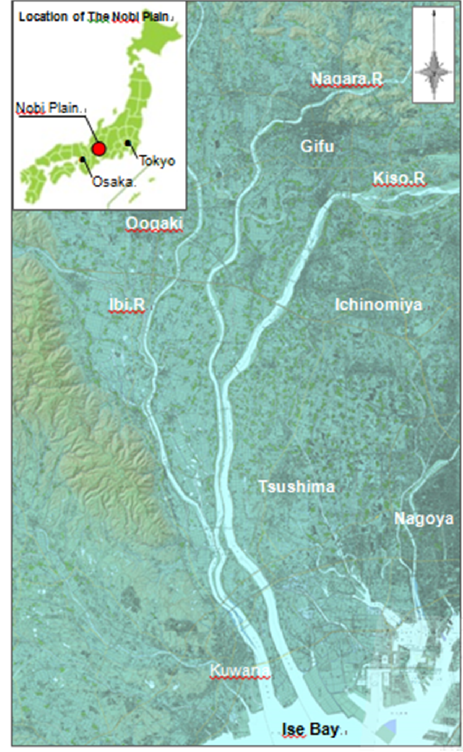
Figure 1. Reserch area and major rivers.